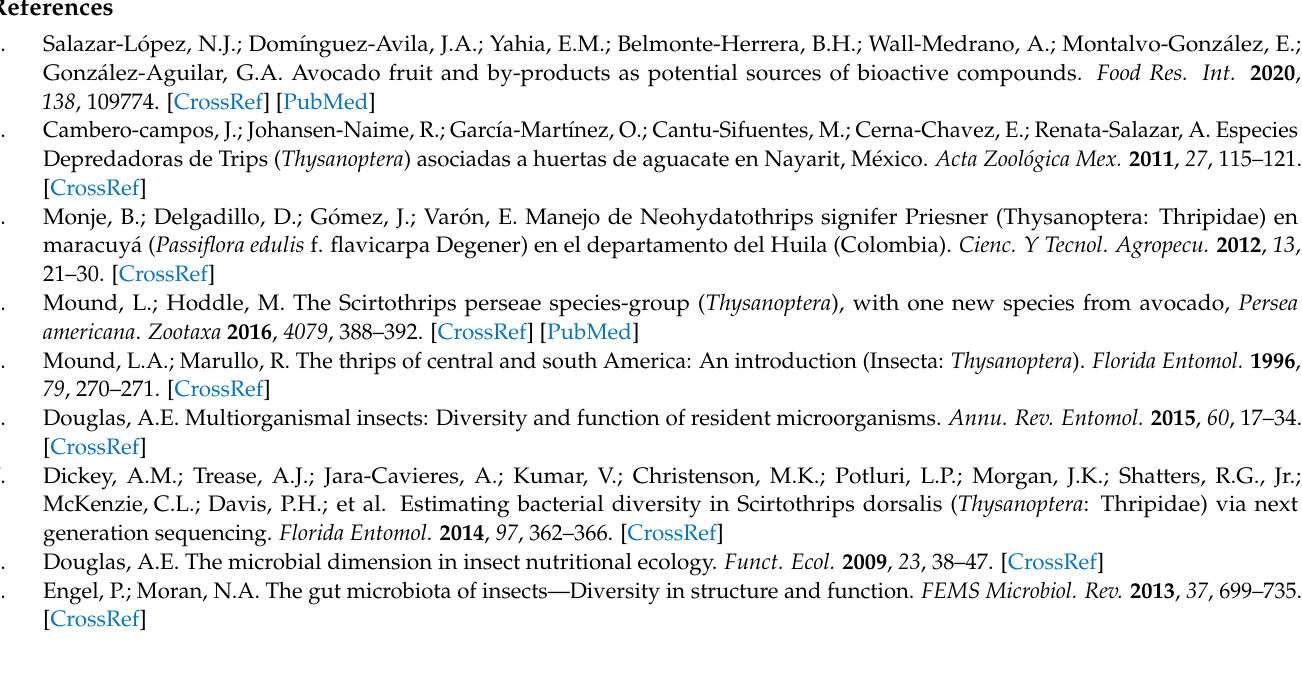
region; Table S6: ANOVA test performed for the diversity indices found for the three morphotypes with V4–V5 region; Table S7: PERMAMOVA test used to compare the bacterial community between three morphotypes based on the Bray Curtis